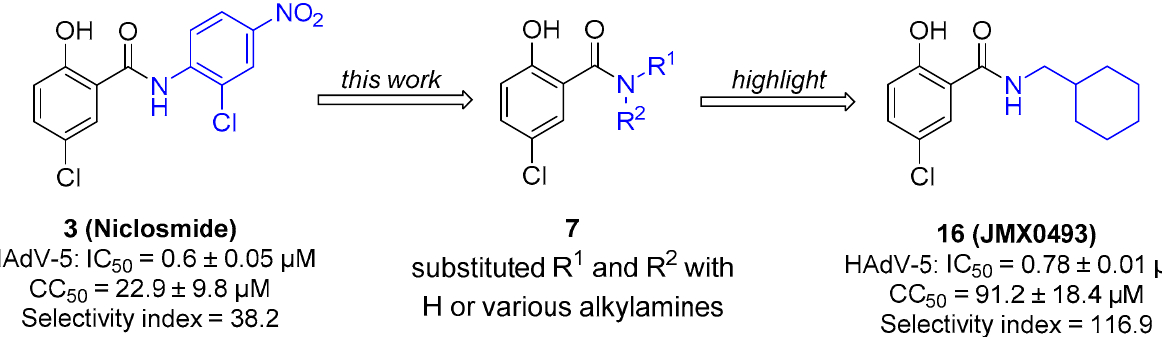
Figure 2. The drug design for this work, which highlights the discovery of new compound 16 (JMX0493) with both improved selectivity index and capability of inhibiting the escape from the endosome of the viral particles.